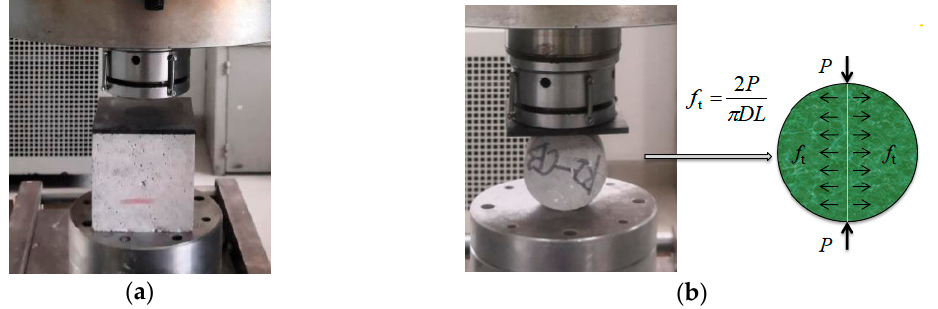
Figure 2. Loading modes of ( a ) static compressive and ( b ) splitting tensile tests.